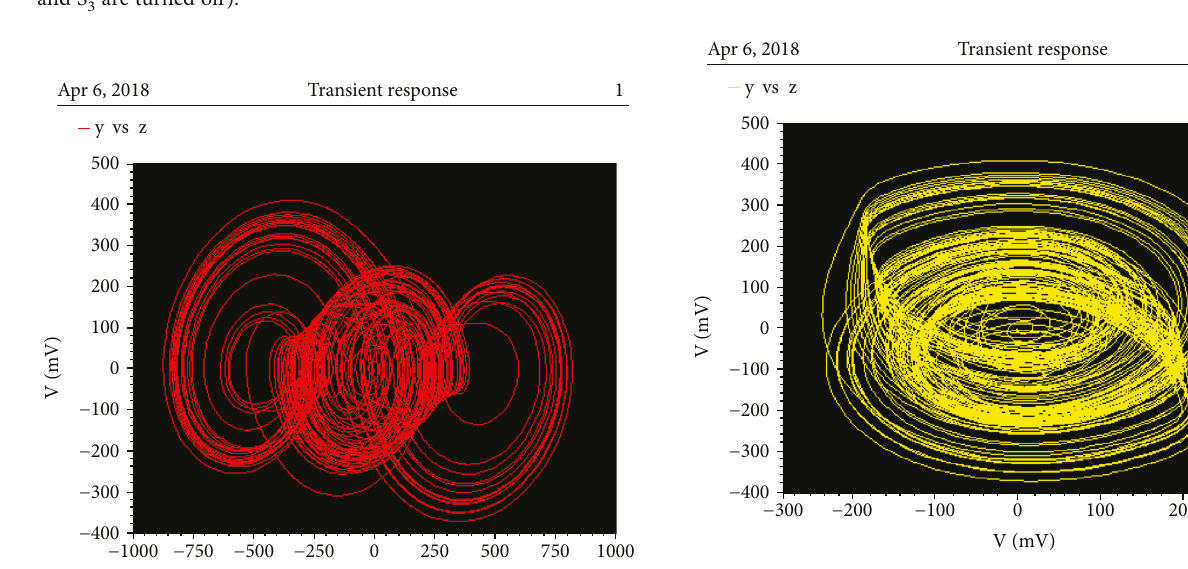
Figure 19: The phase portrait in the y - z plane (S on, S is turned o ff ). 2